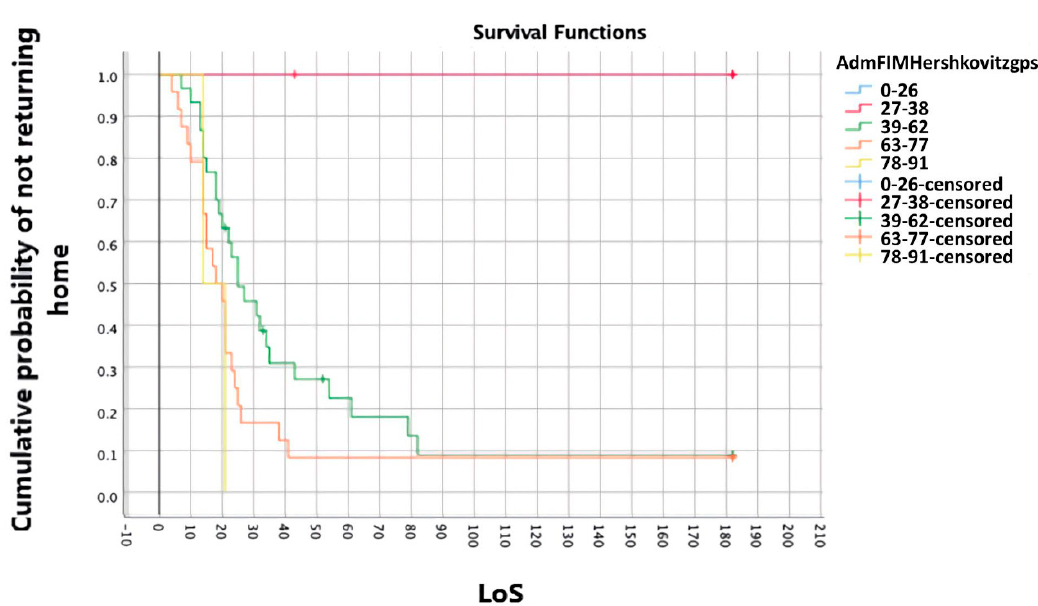
Figure 2. Survivor analysis curve—FIM admission (LoS in days).